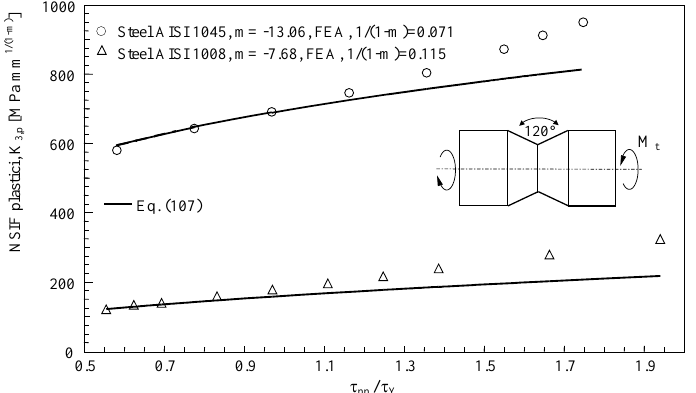
Figura 16: NSIF plastici in accordo con la teoria in confronto con i risultati di analisi agli elementi finiti. Intaglio a spigolo vivo (2 α =120°).